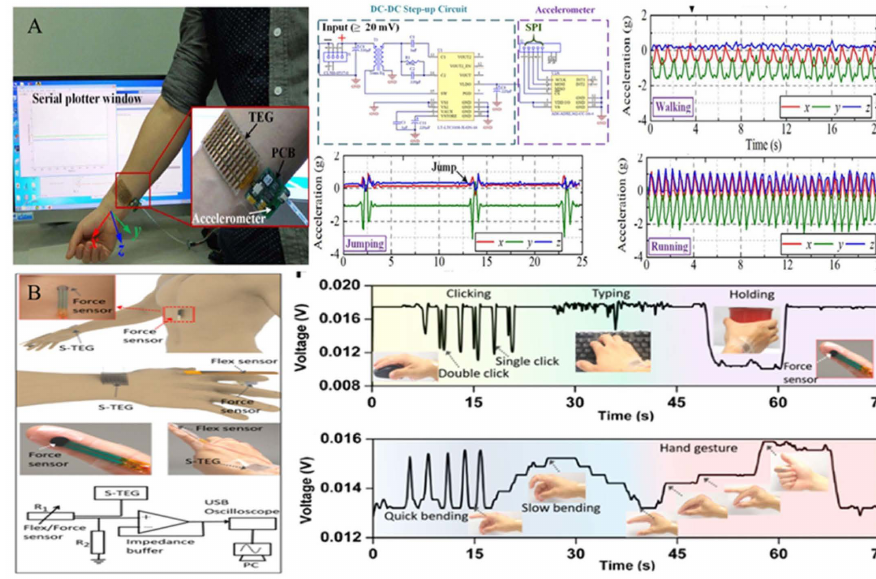
Figure 13. ( A ) Human movement state detection [58]. ( B ) Detection of hand activity [53].